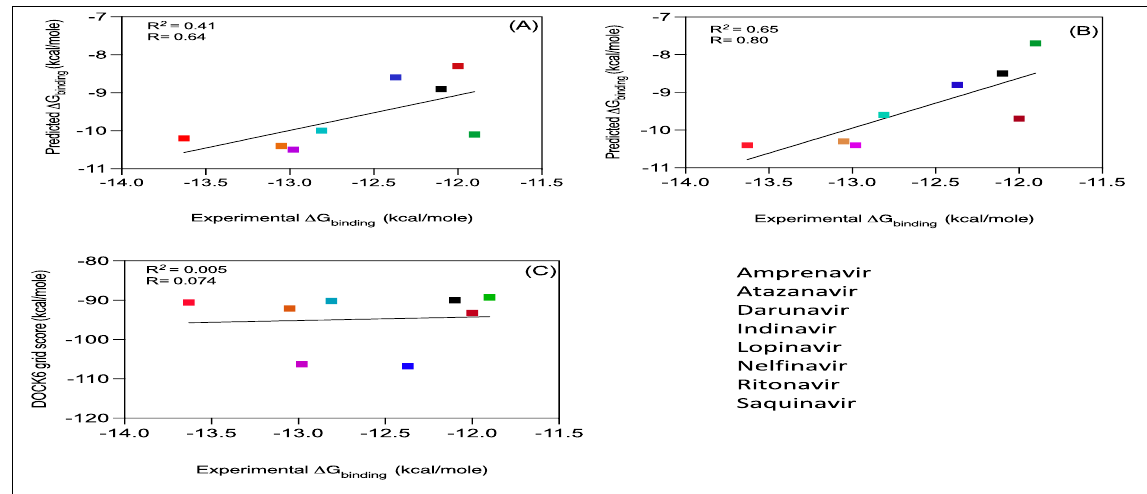
Figure. 5. Correlation between ΔG binding results and experimental results of HIV-1 protease inhibitor drugs. (A) Correlation between experimental results and ΔG binding results using 1-Click Docking. (B) Correlation between experimental results and ΔG binding results using AutoDock Vina. (C) Correlation between experimental results and ΔG binding results using UCSF